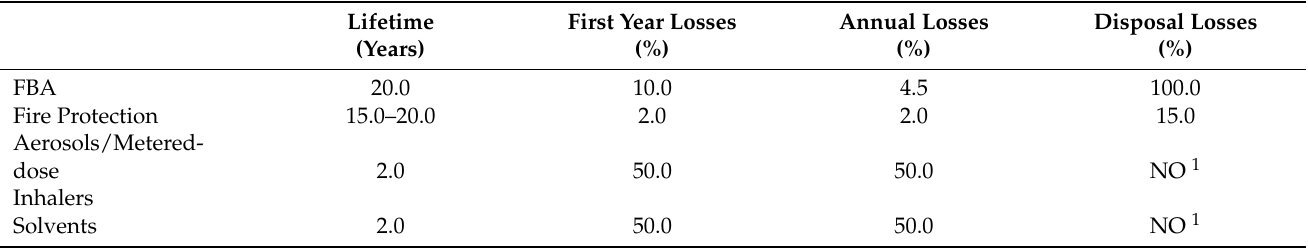
Table 8. EFs used for emission estimation for FBA, fire protection, aerosols/metered-dose inhalers and